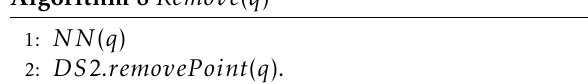
Algorithm 8 Remove ( q )